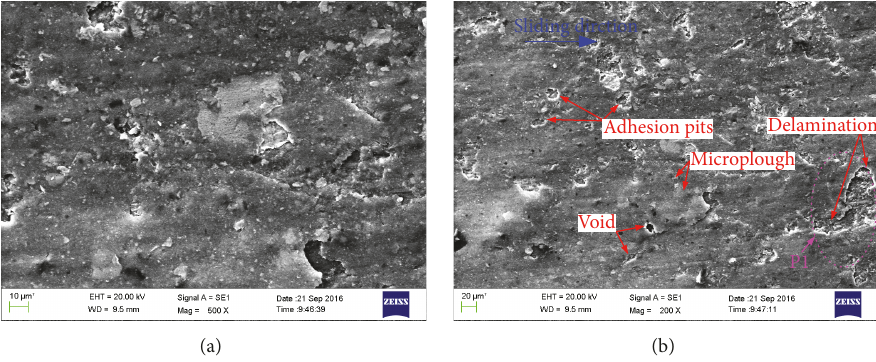
Figure 8: The worn surface topography of composites specimen for the test of 30 ∘ C ∼ 200 ∘ C: (a) 500x and (b) 200x.